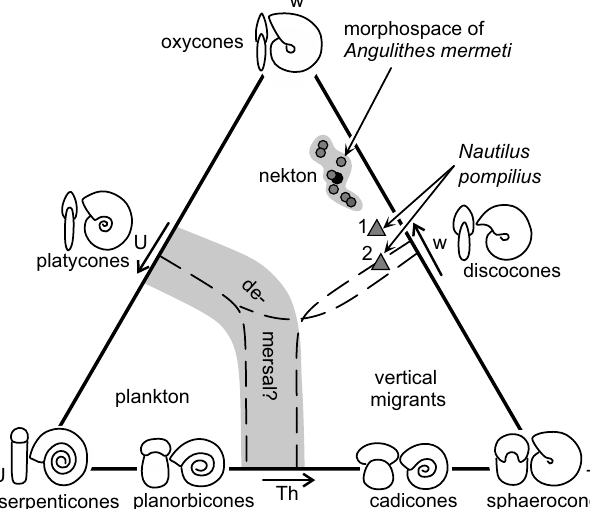
Fig. 8. Westermann morphospace diagram, simplified and modified af- ter Ritterbush et al. (2014), with placement of the hercoglossid nautiloid Angulithes mermeti (Coquand, 1862) (see Table 2 for raw data; black circle indicates mean value); for comparison, two specimens of Nautilus pompilius Linnaeus, 1758 are plotted in the diagram, too (1, specimen 17 of Tajika et al. 2015; 2, an early Pleistocene specimen from Wani et al. 2008). Abbreviations: Th, shell inflation; U, umbilical exposure; w, whorl